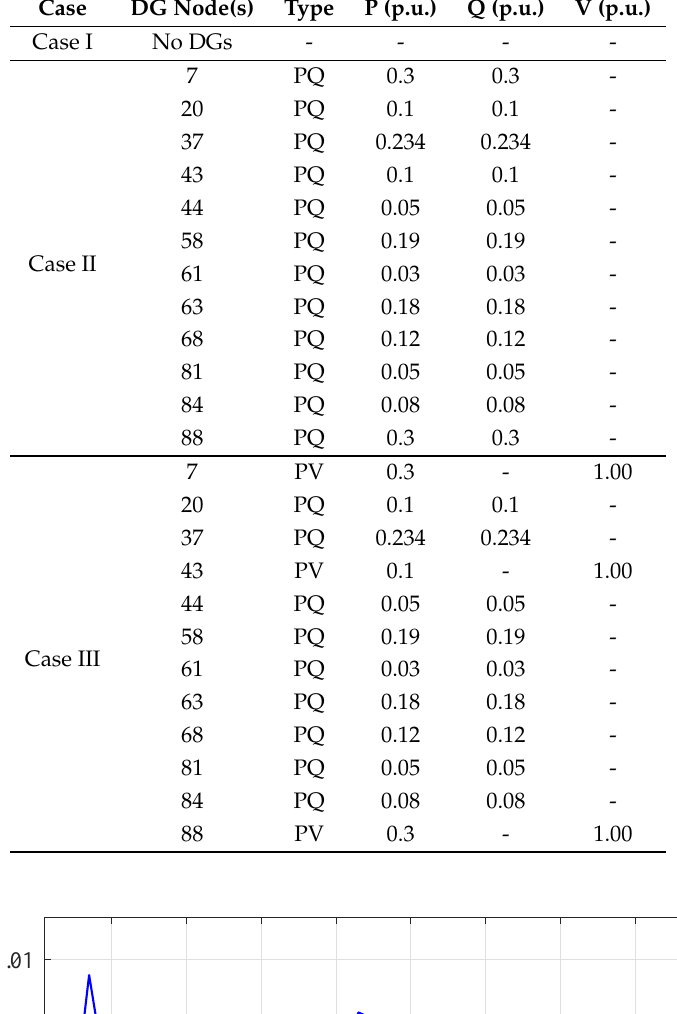
Table 3. Description for different cases of Test90.